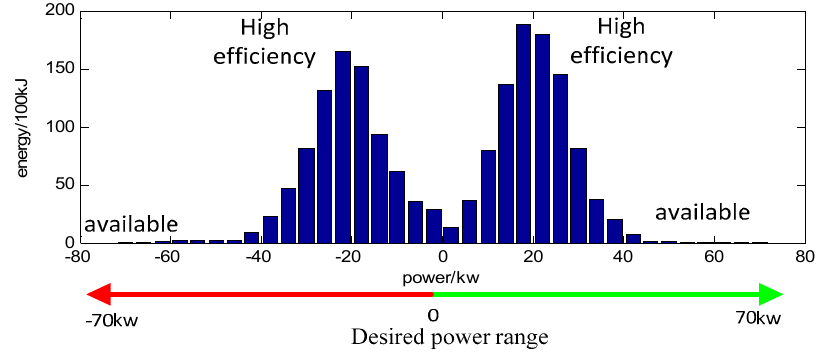
Figure 13. Energy distribution under different charging/discharging power.